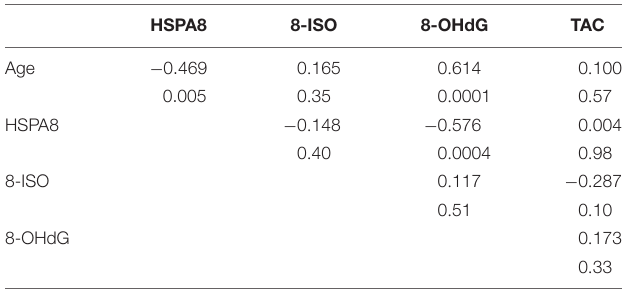
TABLE 2 | Associations between age, HSPA8, 8-OHdG, 8-ISO, and TAC in CSF from 34 healthy subjects. HSPA8